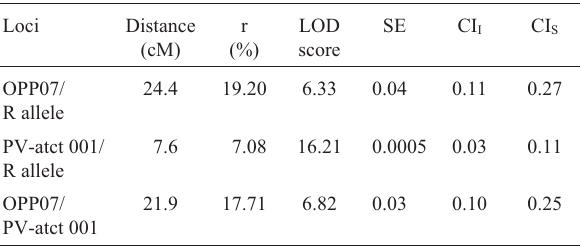
Table 3 - Recombination frequencies (r) between the reaction gene and the markers. considering the pairwise co-segregation. and the respective Haldane distance (cM). LOD score. standard error (SE). and inferior (CI I ) and superior (CI S ) confidence